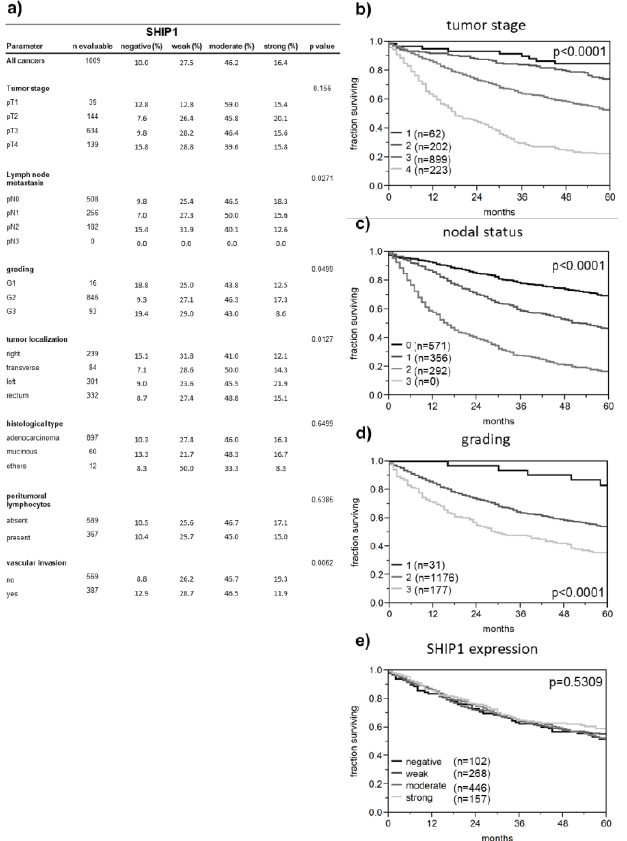
Figure 1. Expression of SHIP1 in carcinomas and sarcomas. ( a ) Lysates from indicated cell lines were